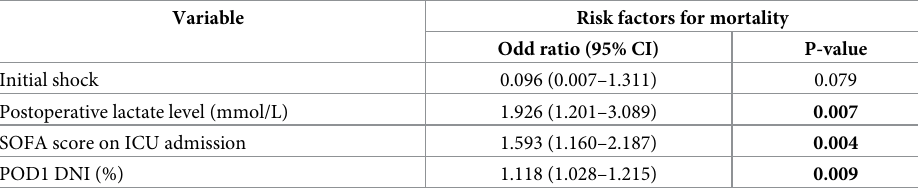
Injury severity score > 15, solid organ injury, combined injury, initial shock, postoperative lactate level, SOFA score on ICU admission, and DNI on POD1 were used as variables for multivariate analysis. CI, confidence interval; DNI,